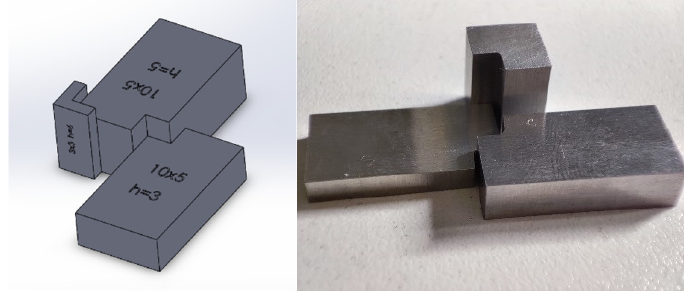
Figure 4. Reference objects for calibration procedure for RMS (model and real part). 6mm measuring standard shown in Figure 5. was used, respecting the same conditions.